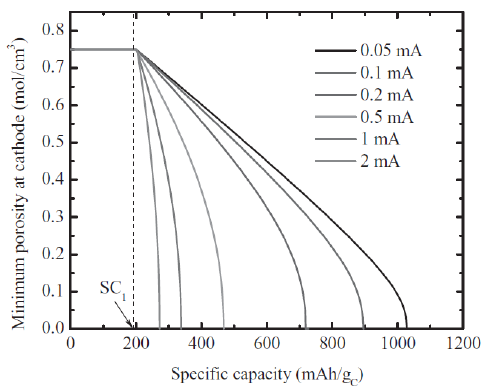
Figure 21. Minimum porosity at the cathode as a function of specific capacity. Republished from Andrei et al. [28] with permission of The Electrochemical Society conveyed through Copyright Clearance Center, Inc.